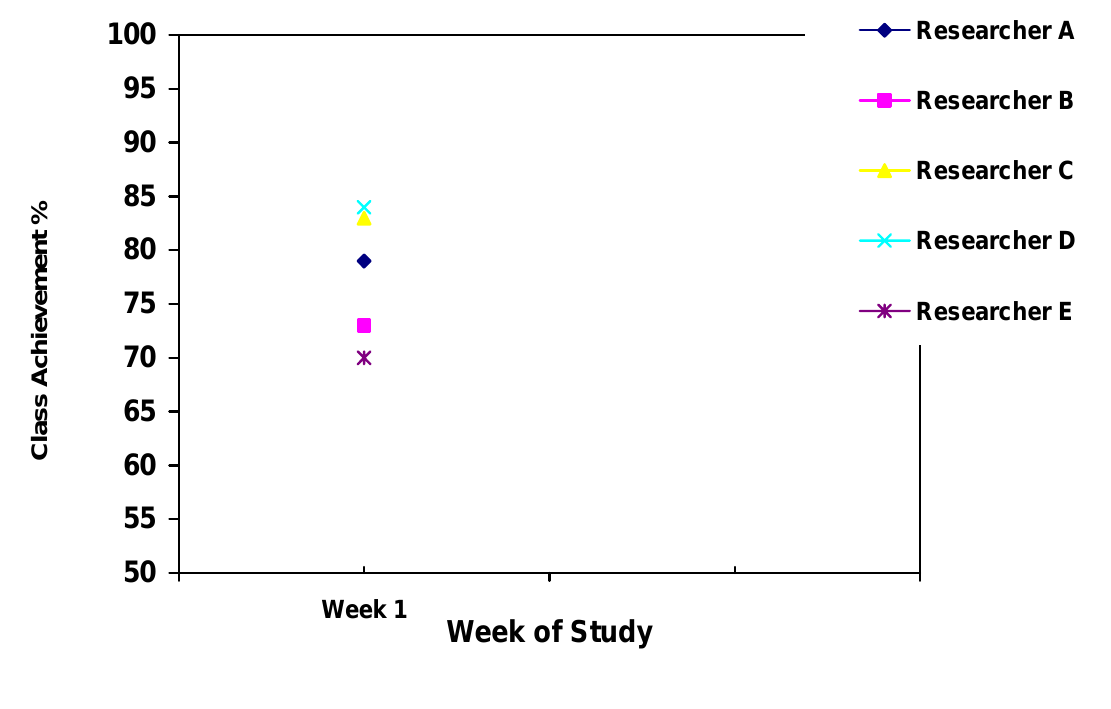
Figure 5. Class Achievement Record during week one prior to implementation of posting and communicating daily learning